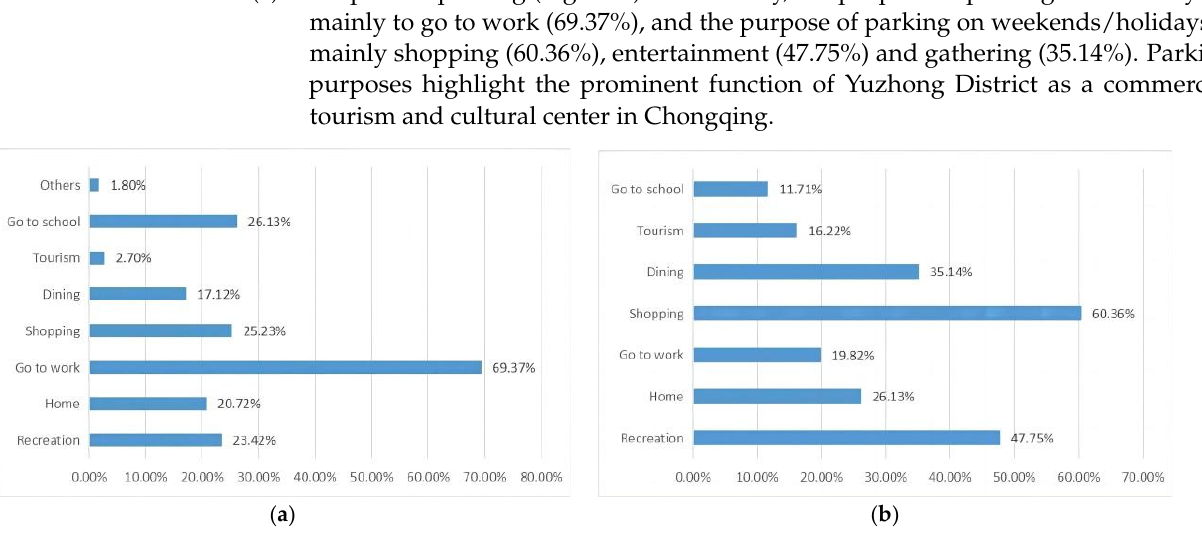
Figure 6. Parking purpose on weekdays and holidays. ( a ) Purpose of parking on weekdays, ( b ) Parking purpose on weekends and holidays.